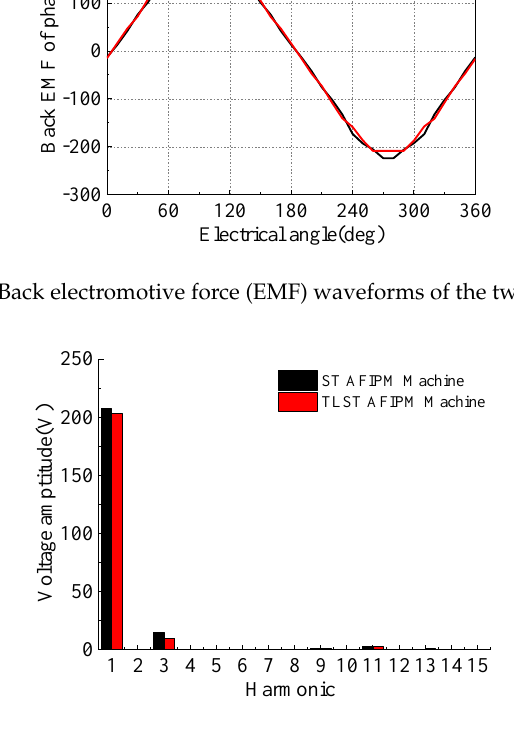
Figure 16. The comparison of harmonics of back EMF waveforms.